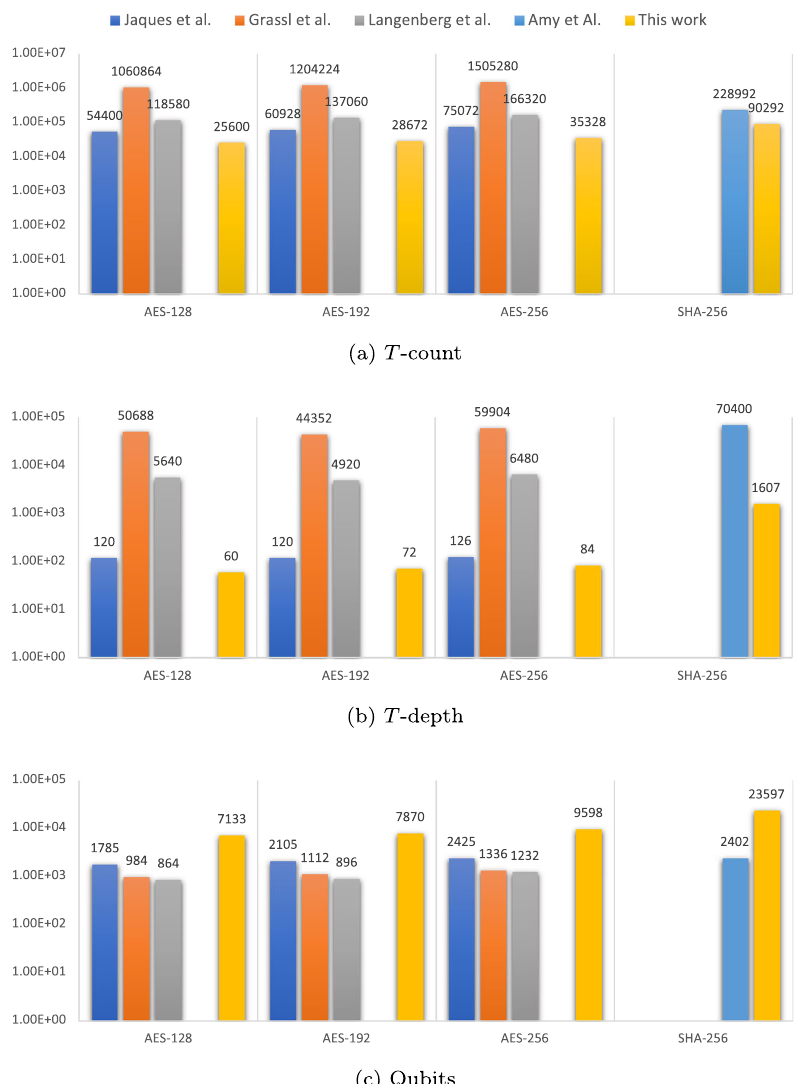
Fig. 2 Resource estimates for AES-128/192/256 and SHA-256 compared with the state-of-the art: Jaques et al. 12 , Grassl et al. 11 , Langenberg et al. 17 and Amy et al. 15 . a Histogram comparing the number of T gates; b histogram comparing the T -depth; c histogram comparing the number of